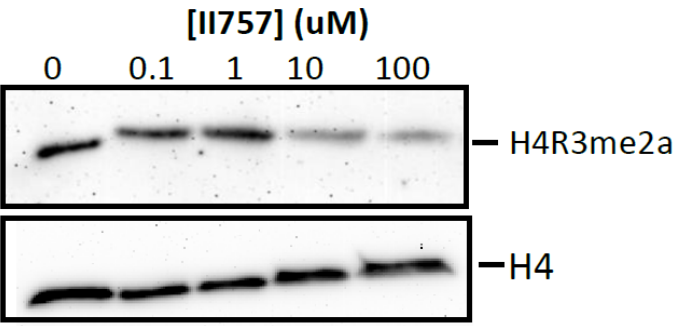
Figure 9. Cellular arginine methylation assay of II757 in HEK293 cells. Representative Western blot results of effects of II757 on histone H4 Arg3 asymmetric dimethylation (H4R3me2a) level at 0, 0.1, 1, 10, and 100 µ M. H4 blot is shown as a loading